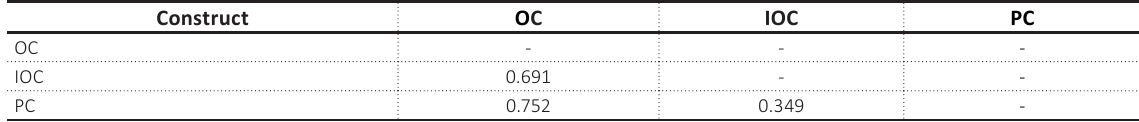
Table 3. Discriminant validity